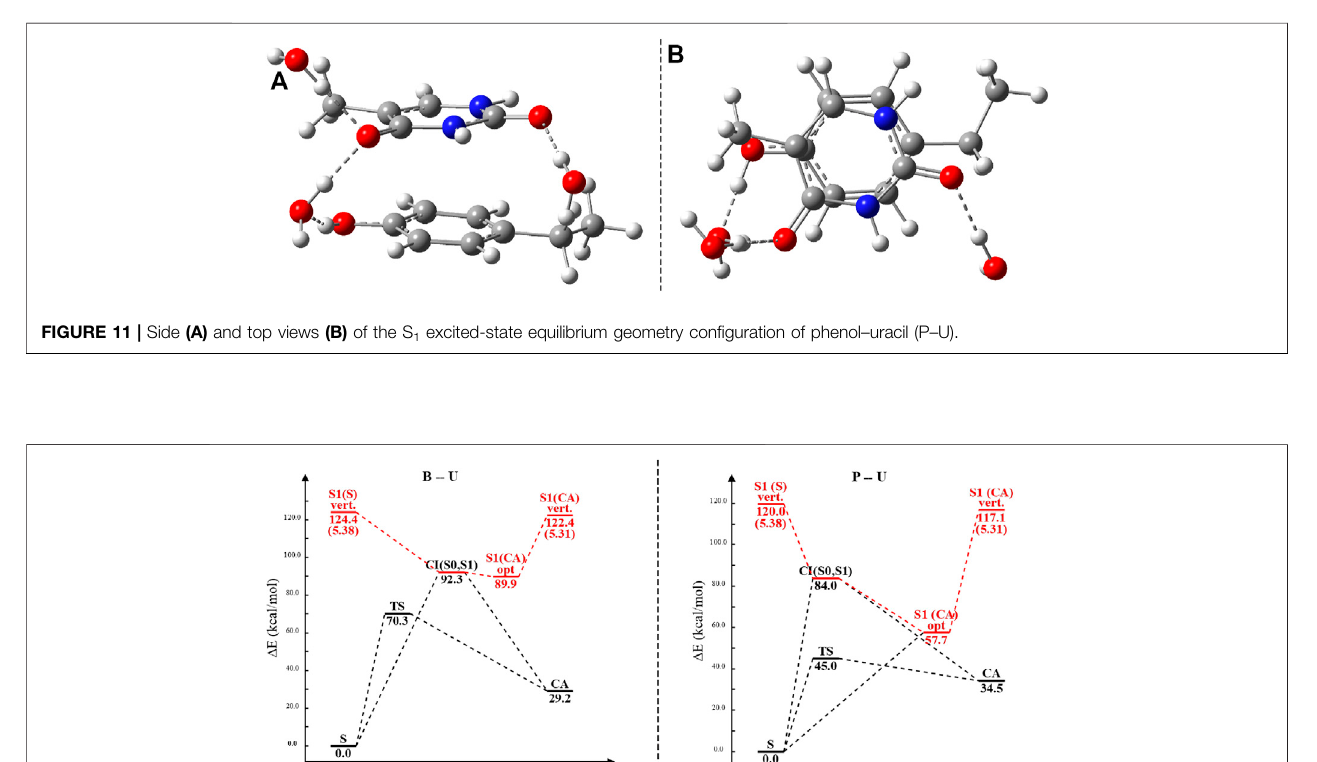
Frontiers in Bioengineering and Biotechnology |